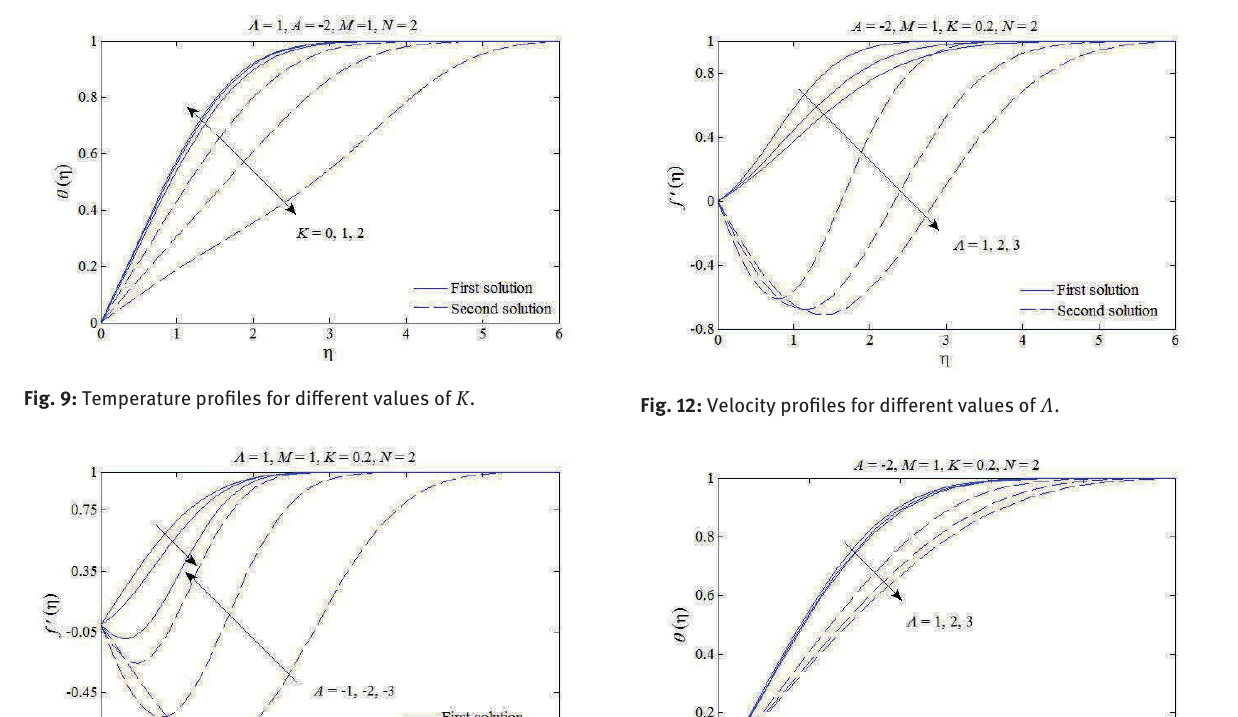
Fig. 11: Temperature profiles for different values of A .